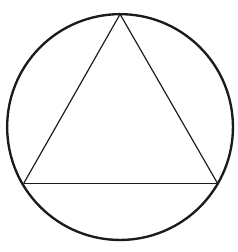
Figure 1. Scalar triangle diagram contributing to the latitude Wilson